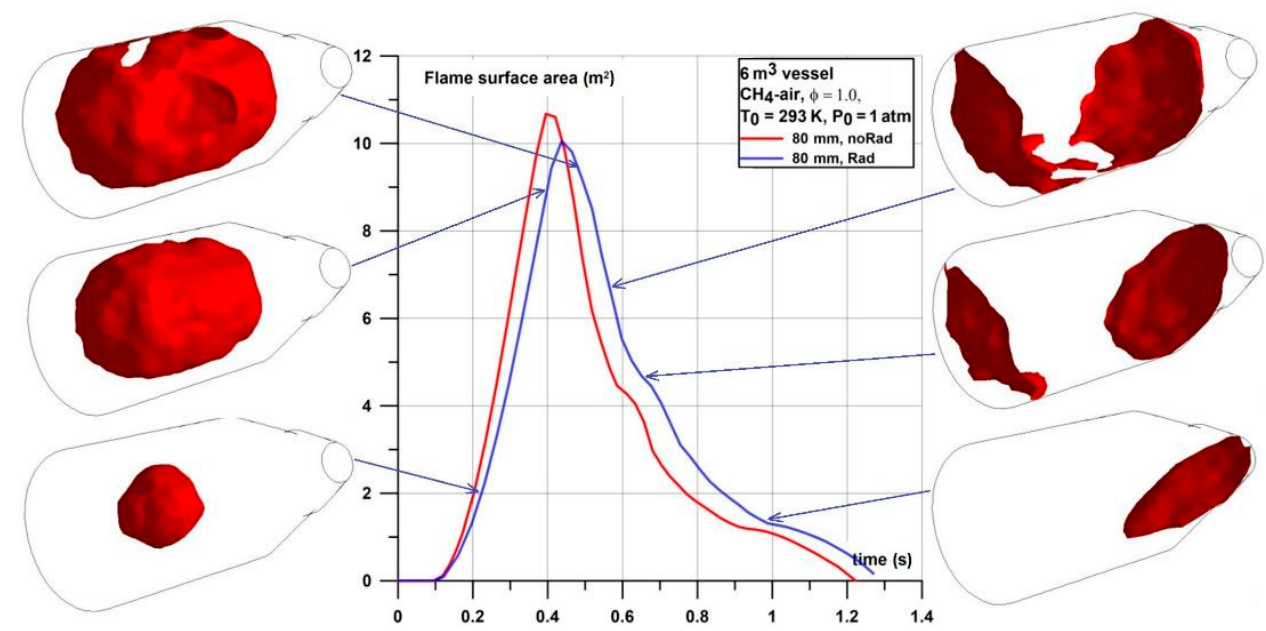
Figure 11. Flame surface area development curve with flame surface (iso-surface of progress variable of value 0.5) at selected times.